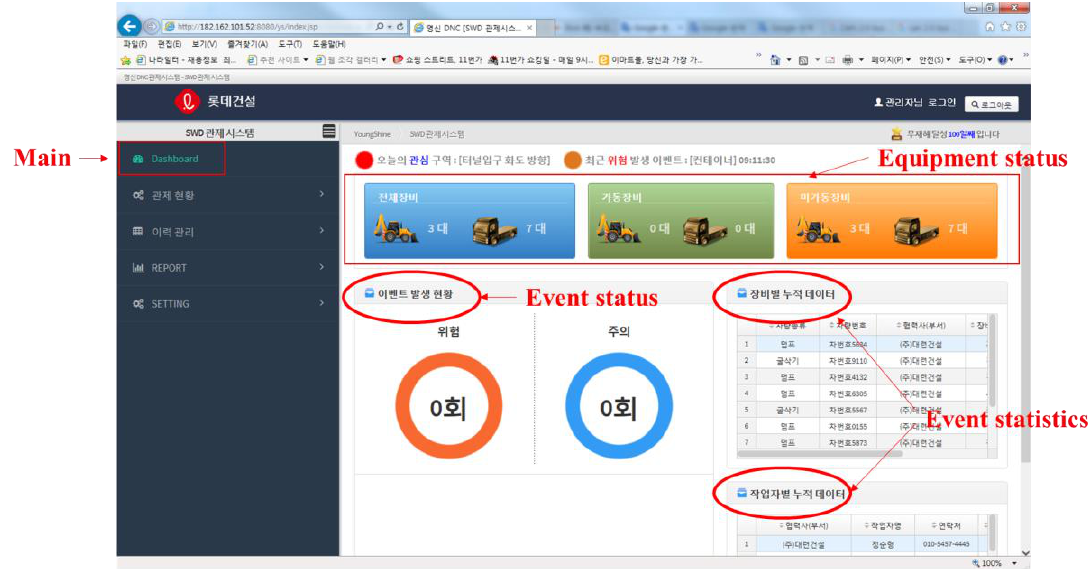
Figure 18. Main interface. Sensors 2019 , 17 , x FOR PEER REVIEW